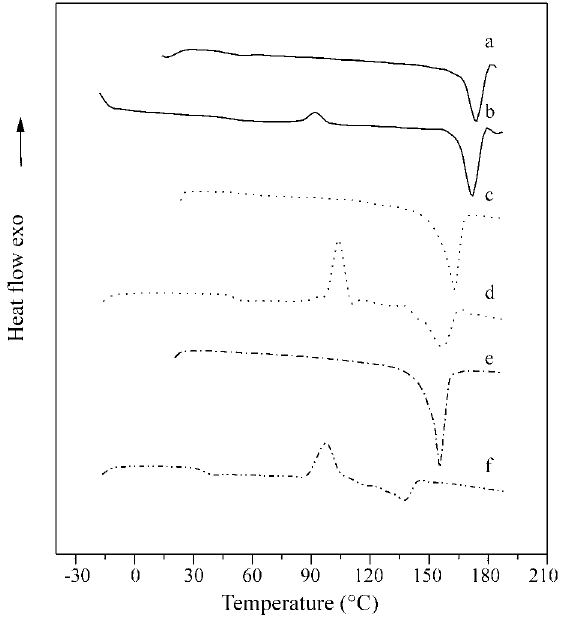
Figure 2. DSC curves for PLLA/PHBV 60/40 blends submitted to differenthydrolytic degradation periods, firstheating(a, c, e)for 0, 36 and 53 weeks, respectively and second heating (b, d,f) for 0, 36 and 53 weeks, respectively.